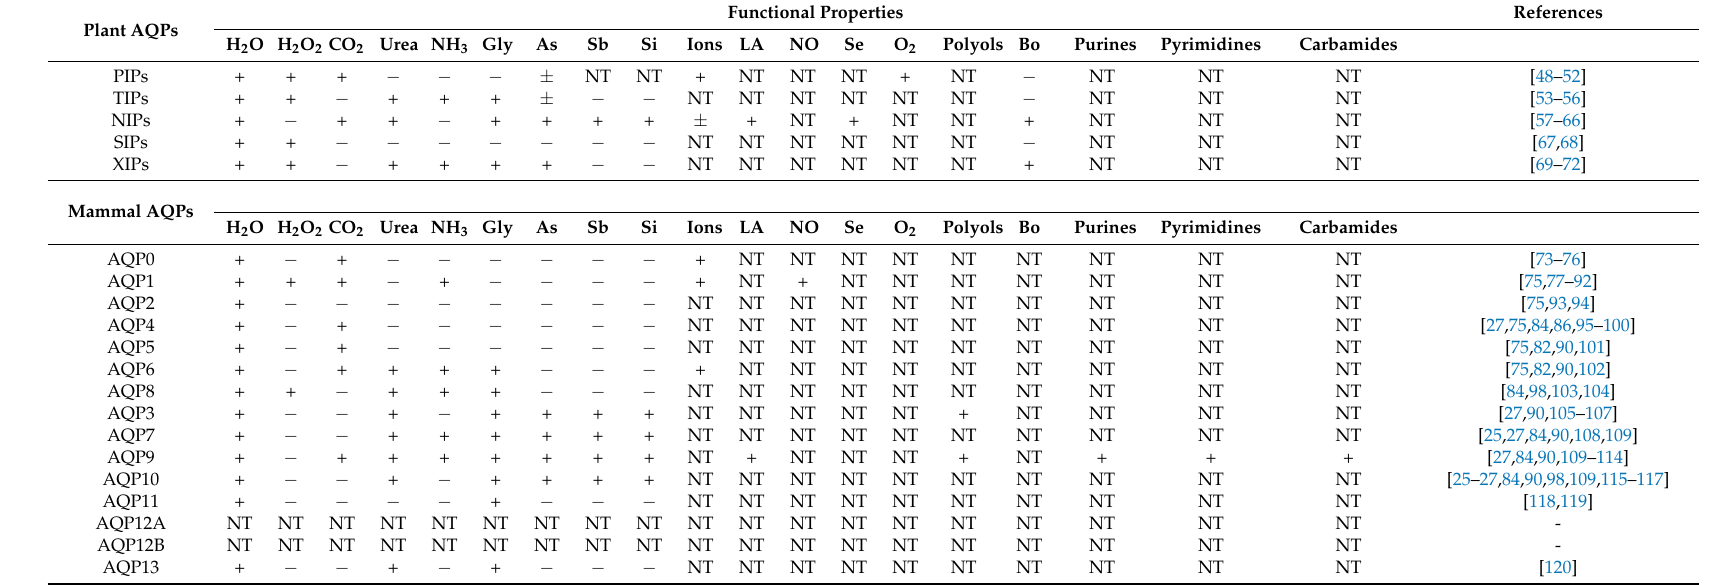
Table 1. Functional properties of plant and mammalian aquaporins (AQPs). The substrates transported by plant and mammalian AQPs are shown in following table: H 2 O, water; H 2 O 2 , Hydrogen peroxide; CO 2 , carbon dioxide; Urea; NH 3 , ammonia; Gly, glycerol; As, arsenic; Sb, antimony; Si, silicon; Ions; LA, lactic acid; NO, Nitric oxide; Se, selenium; O 2 , oxygen; Polyols; Bo, boric acid; Purines; Pyrimidines; Carbamides and also corresponding references. PIPs, plasma membrane intrinsic proteins; TIPs, tonoplast intrinsic proteins; NIPs, noduline26-like intrinsic proteins; SIPs, small basic intrinsic proteins and XIPs, uncharacterized X intrinsic proteins. Plant